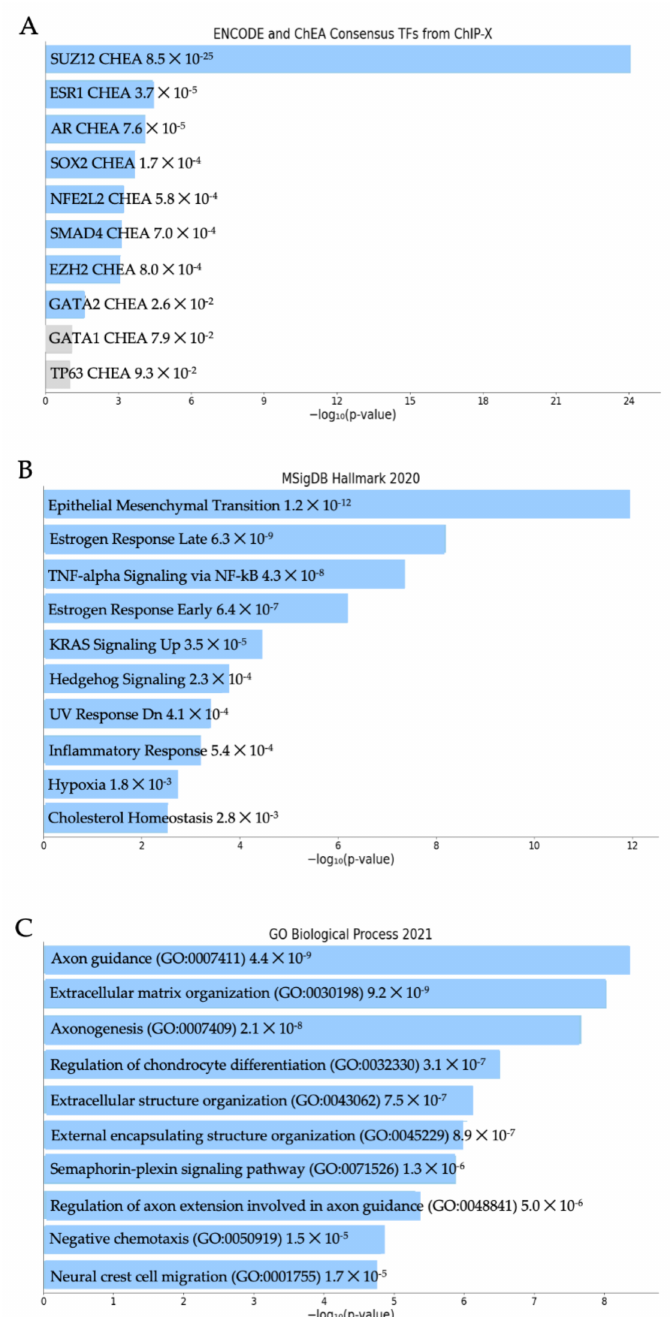
Figure 3. The top ( A ) ENCODE and ChEA Consensus TFs from ChIP-X, ( B ) MSigDB Hallmark 2020, and ( C ) GO Biological Process 2021 identified in Enrichr using the 2843 differentially expressed genes in MDA-231EV tumors compared to MDA-231c141